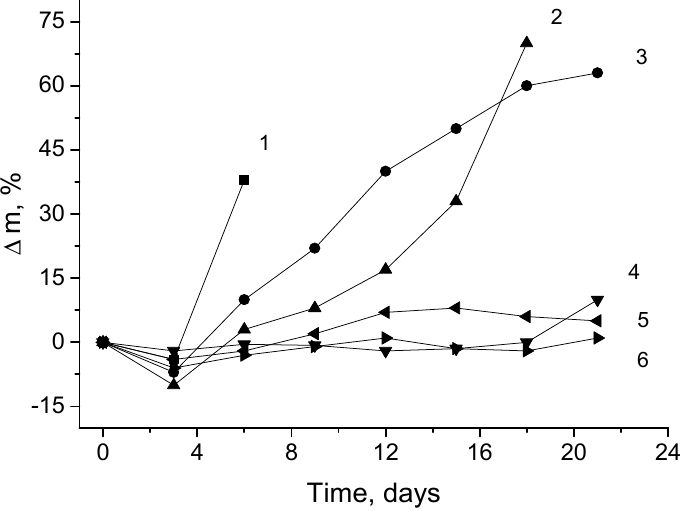
Figure 2. The biopolymer weight loss kinetics during exposure in the phosphate buffer, where PHB:PLA (wt.%): 1—0:100; 2—10:90; 3—50:50; 4—70:30; 5—90:10; 6—100:0.